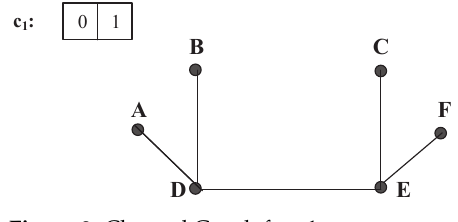
Figure 2. Channel Graph for c 1.